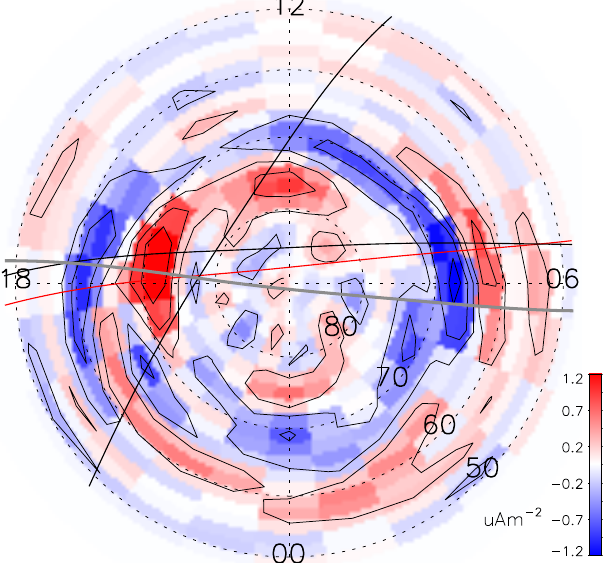
Fig. 15. J mod obtained from the radar electric field data for 3 k October, 2003 as shown in Fig. 11 and the conductance model (see text). The contours of the currents, J obtained from the satellite k data are overlayed and shaded regions indicate no radar